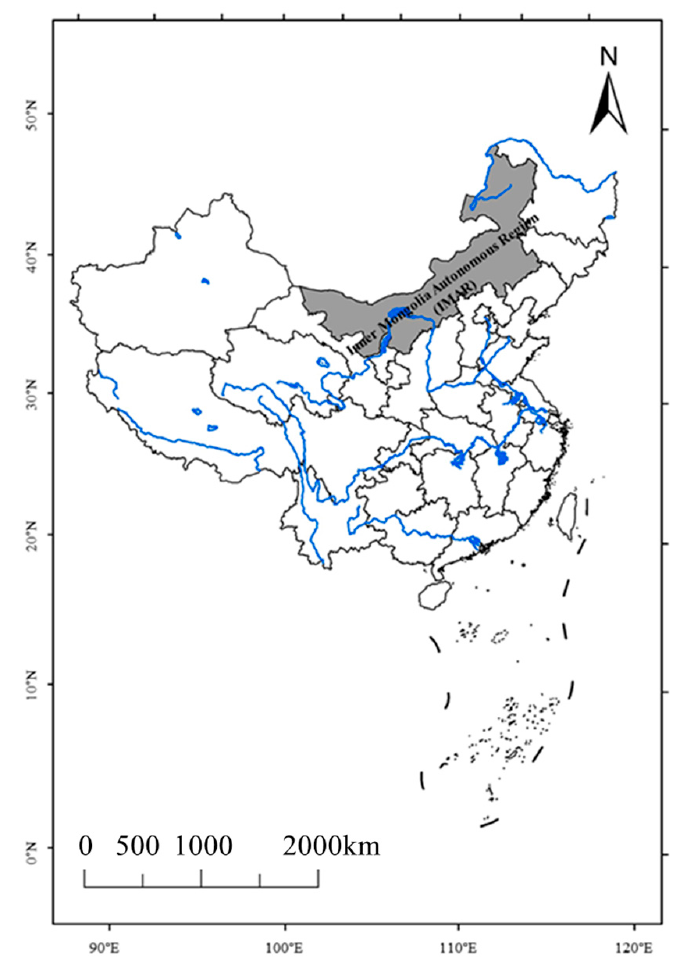
Figure 2. Location of Inner Mongolia Autonomous Region.